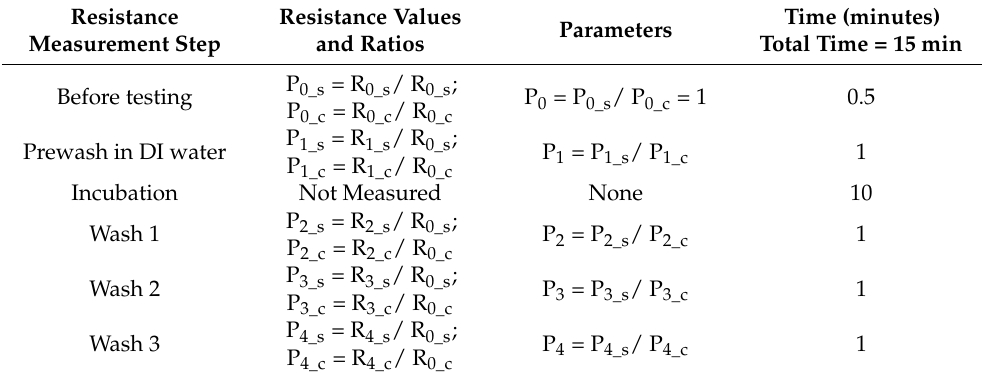
Table 1. Screening protocol, resistance measurement, parameters, and screening